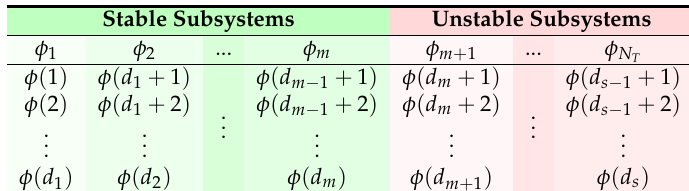
Table 2. The schematic table for Assumption